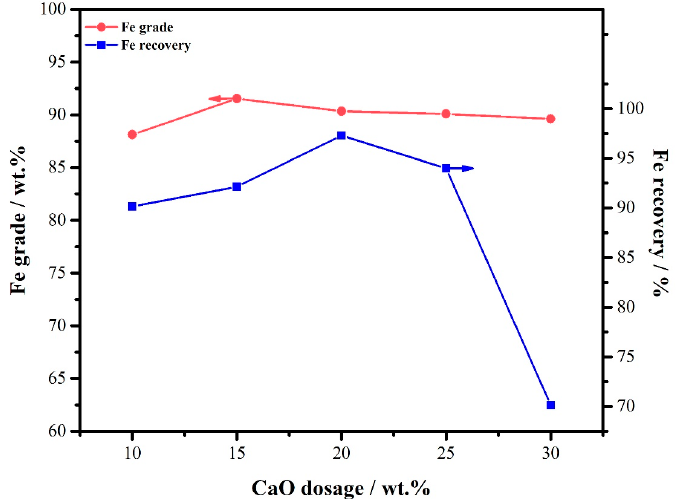
Figure 9. The effects of the CaO dosage on the Fe grade and recovery. Figure 9. The e ff ects of the CaO dosage on the Fe grade and